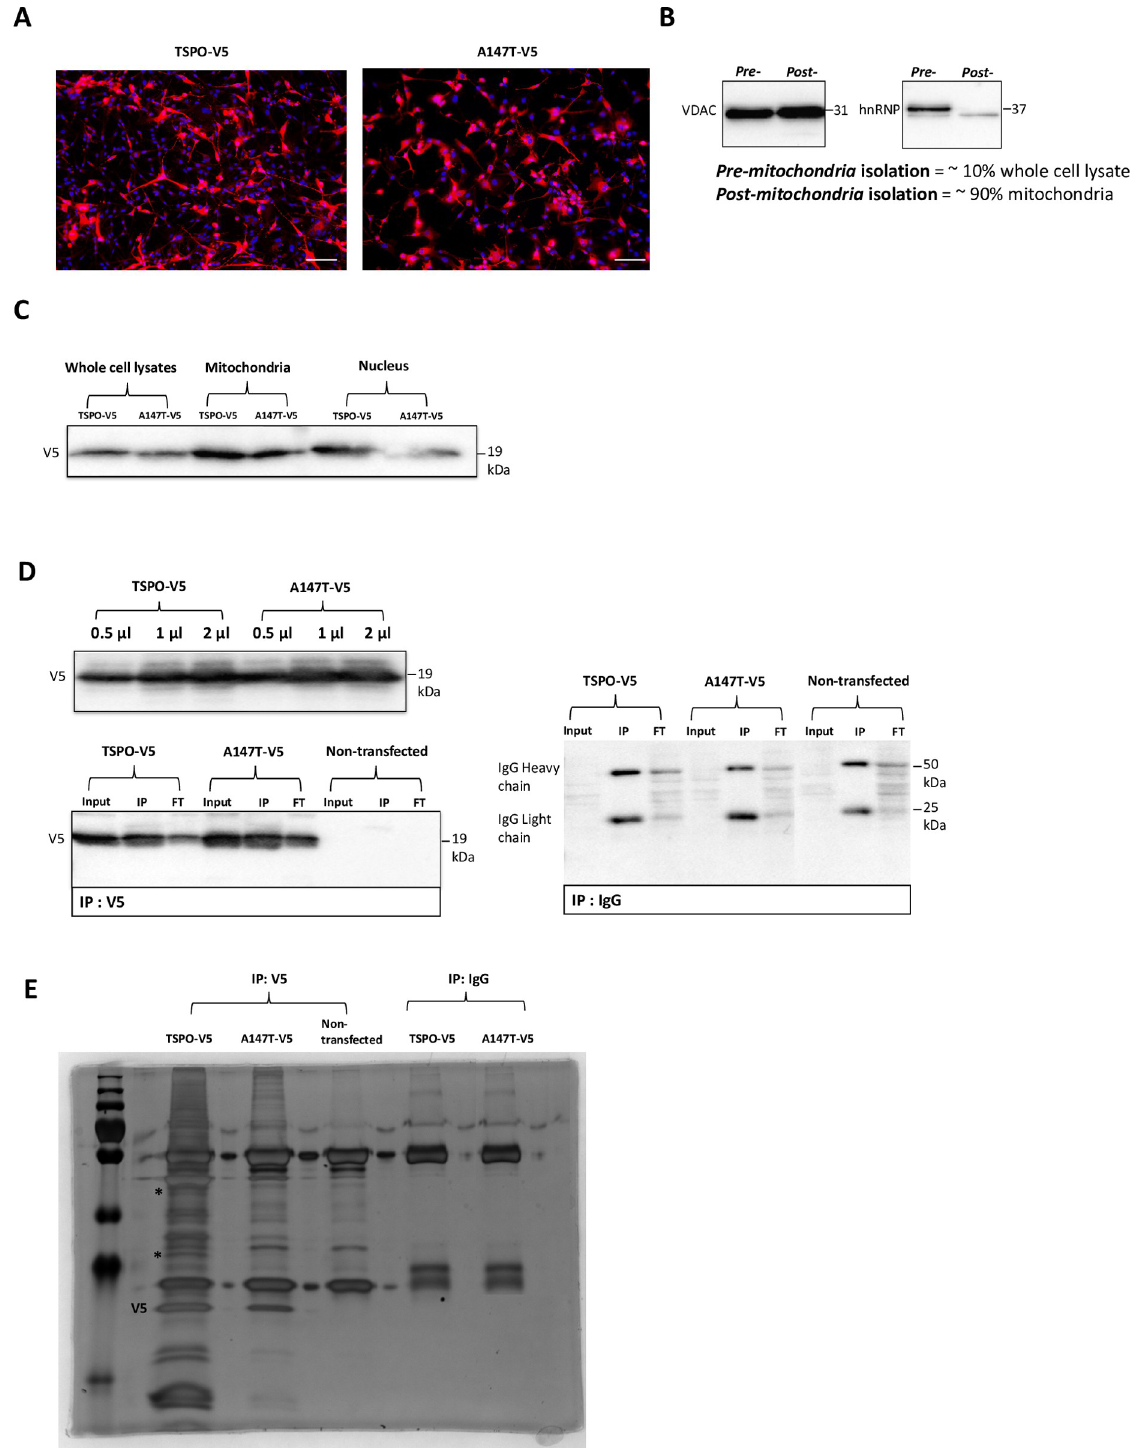
Fig 1. Optimization of sample preparation for the identification of binding partners between human TSPO and its mutant A147T by IP-MS. A) Transfection efficiency of V5-tagged TSPO WT and TSPO A147T in U87MG cells (42.6% ± 5.93), indicating equal protein expression levels; red , anti-V5 immunofluorescence and blue , DAPI indicating cell nuclei. n = 3. B) Mitochondrial enrichment of U87MG cells as assessed by Western blot for VDAC as a mitochondrial marker protein and hnRNP as a nuclear marker protein, indicating that purified mitochondria were isolated, n = 2. C) Representative immunoblot of mitochondrial lysates from transfected U87MG cells with V5-tagged